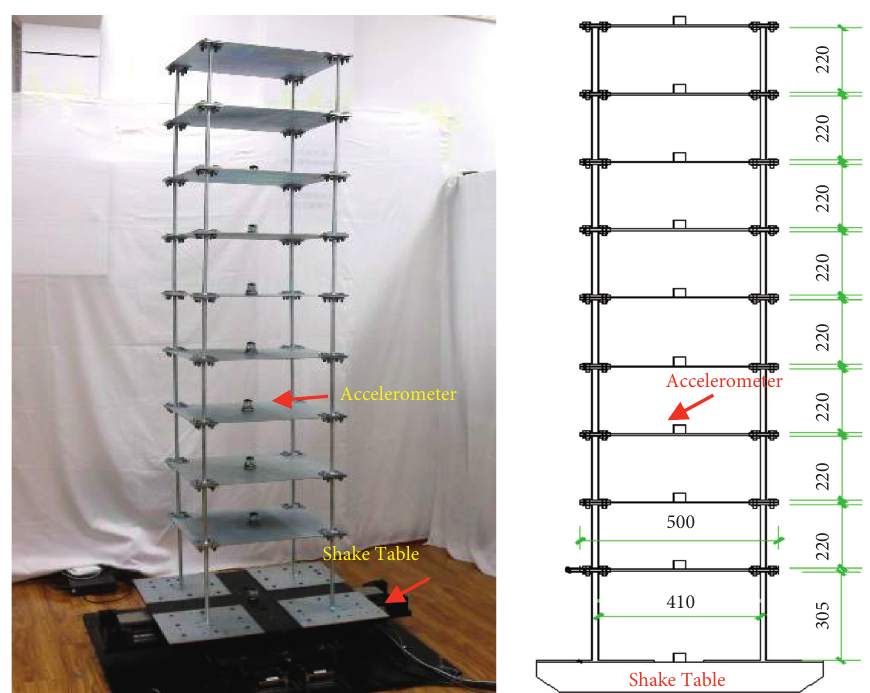
Figure 15: Photograph of tested model structure on the shake